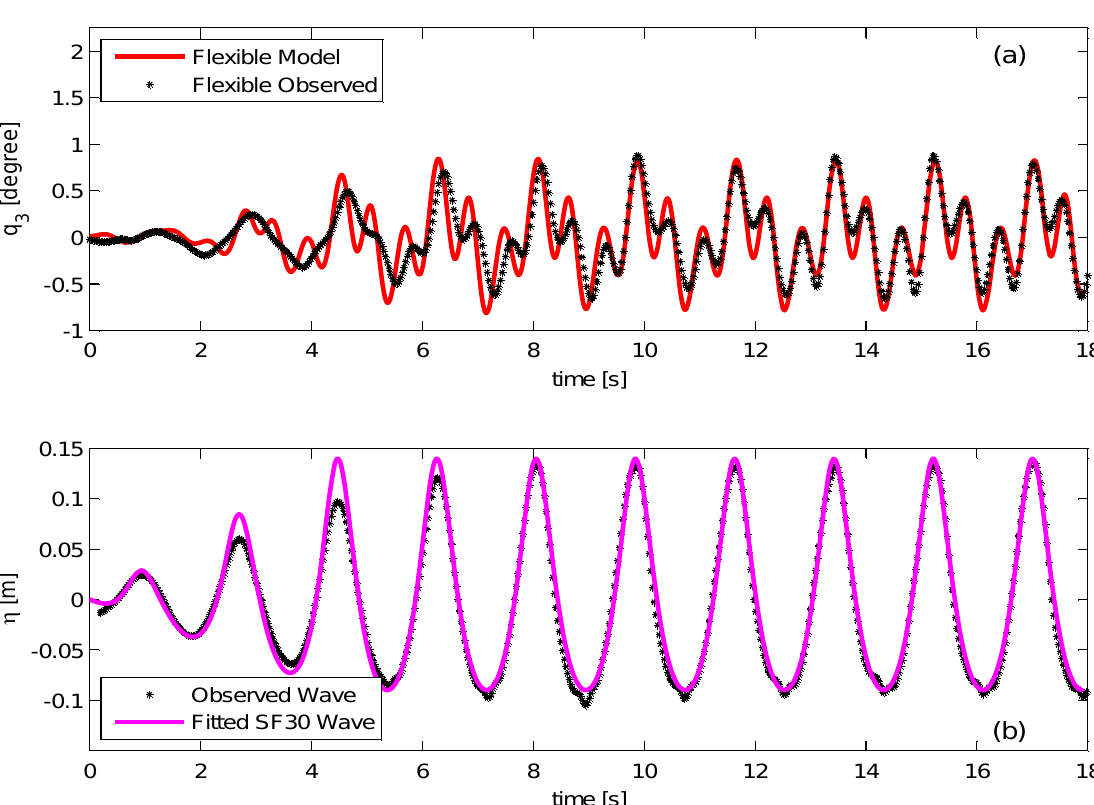
Figure 10. Code-to-experiment comparison between the flexible hybrid model and experimental data under regular wave load conditions. ( a ) Pitch motion comparison; ( b ) Surface elevation